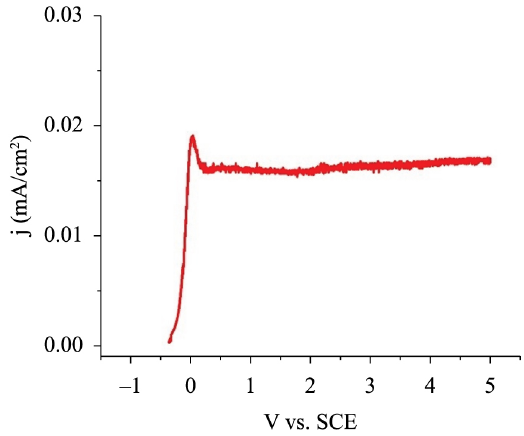
Figure 2. Potential sweep profile for tantalum oxide obtained up to 5 V (50 mV/s) in H